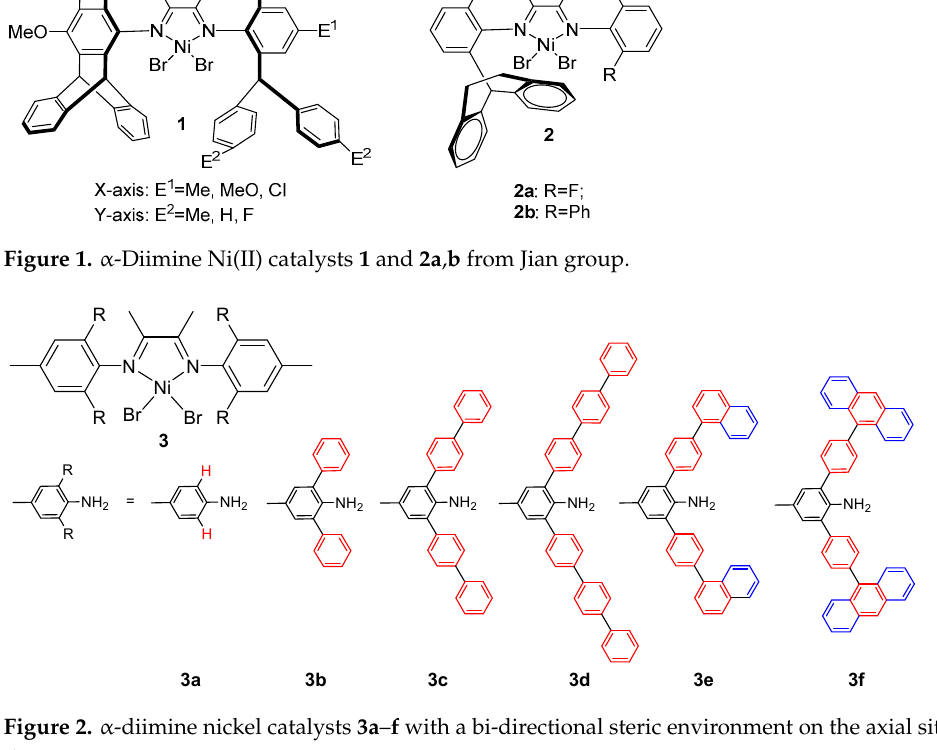
Figure 2. α -diimine nickel catalysts 3a – f with a bi-directional steric environment on the axial sites of the active species.